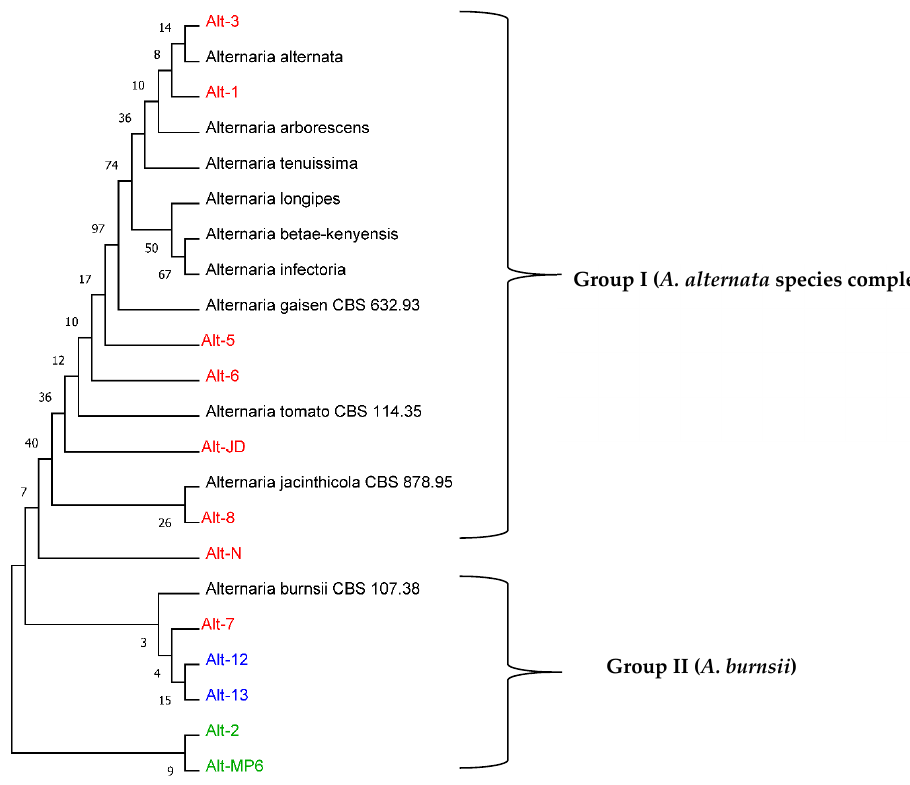
Figure 7. Multi-locus sequence analysis (MLSA) using three genomic regions (ITS, LSU and TEF- α ) of different isolates of Alternaria characterized in the current study. The Maximum Likelihood tree was drawn using MEGA XI with 1000 bootstraps. Isolates in red were of morphotype I, those in blue of morphotype II and those in green of morphotype III. For multi-locus phylogeny of Colletotrichum isolates, sequences for species belonging to the Colletotrichum gloeosporioides species complex were retrieved [62]. In total, 52 species were included in the analysis, along with 17 isolates characterized in the current study.